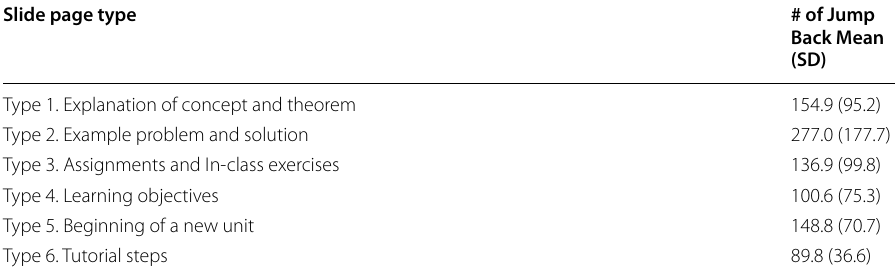
Table 5 Slide types